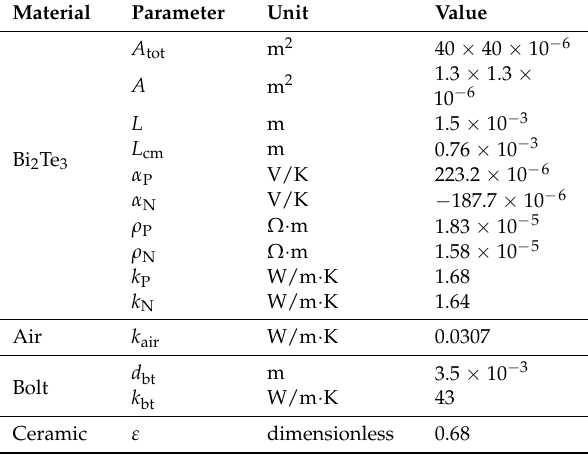
Table 1. Dimensions and physical properties of the thermoelectric (TE) module, fixing bolts and air.